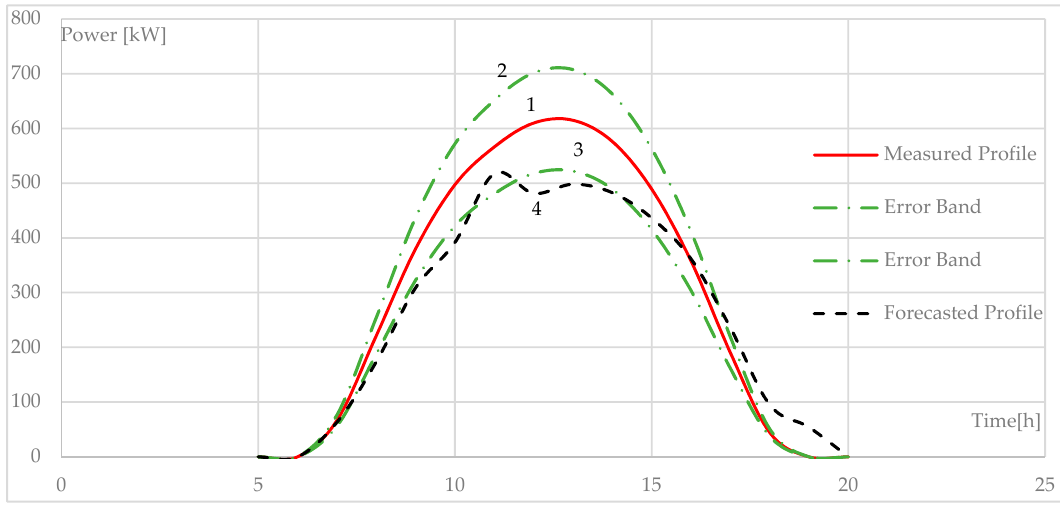
Figure 7. Comparison with the method implemented in [14] for clear sky profiles.